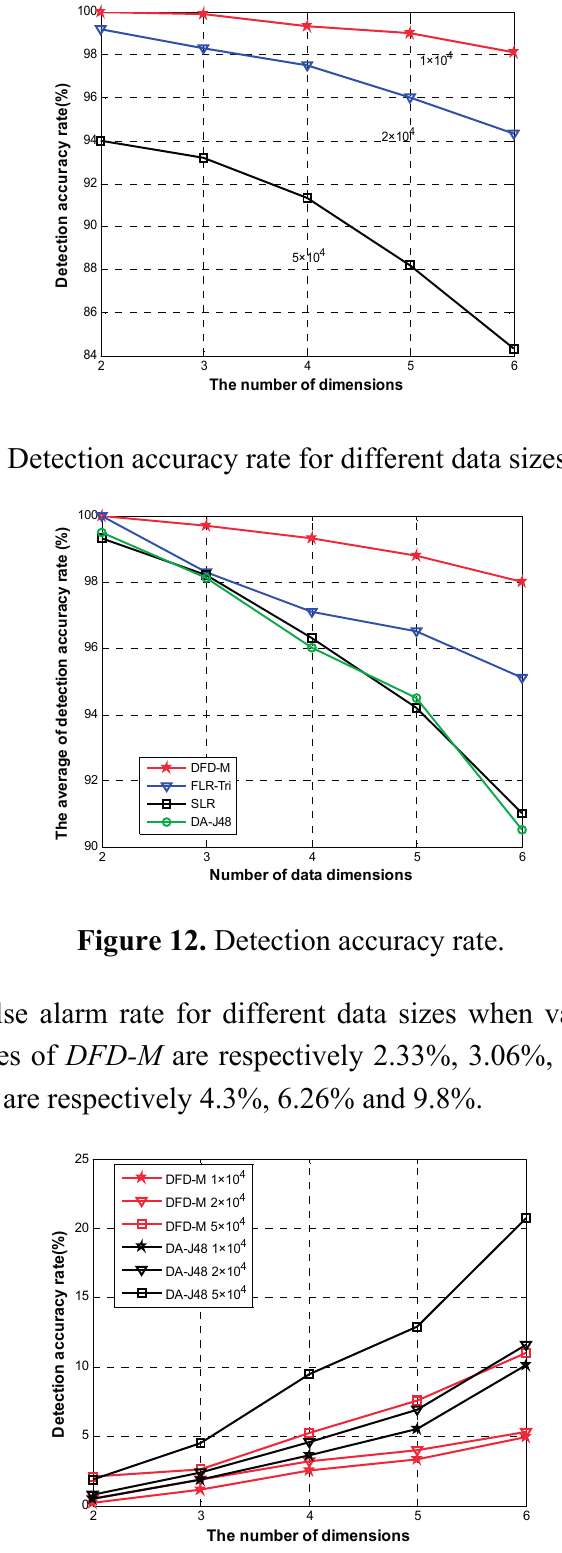
Figure 13. False alarm rate for different data